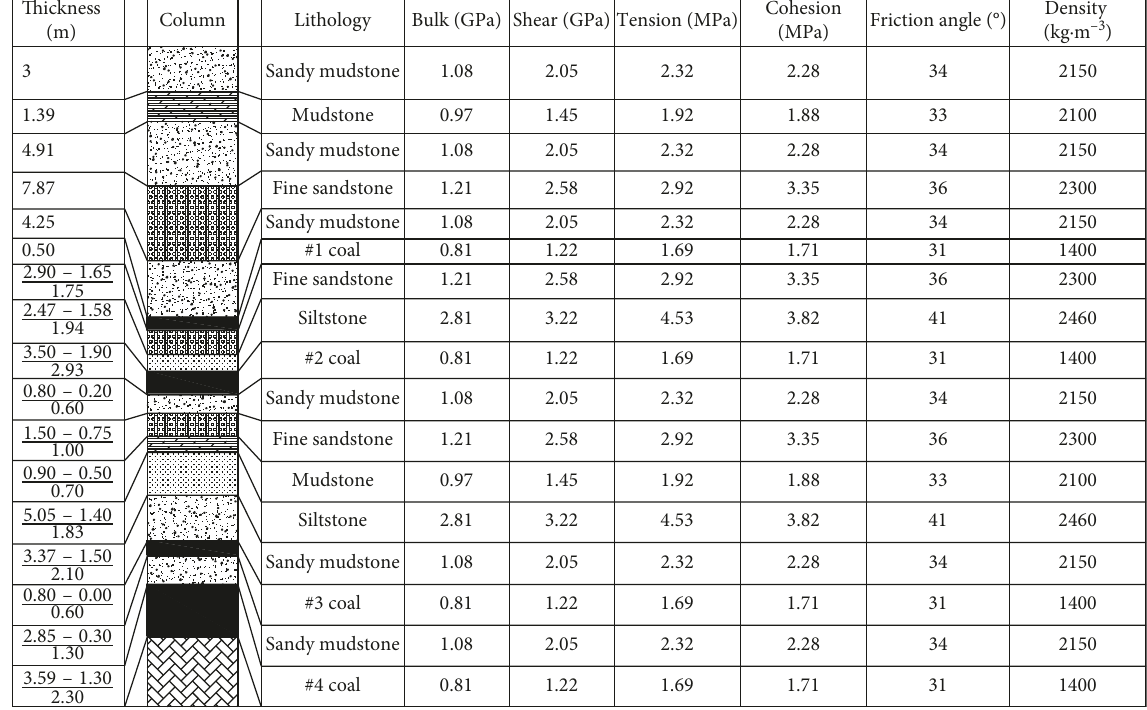
Figure 4: Coal seam stratum synthesis